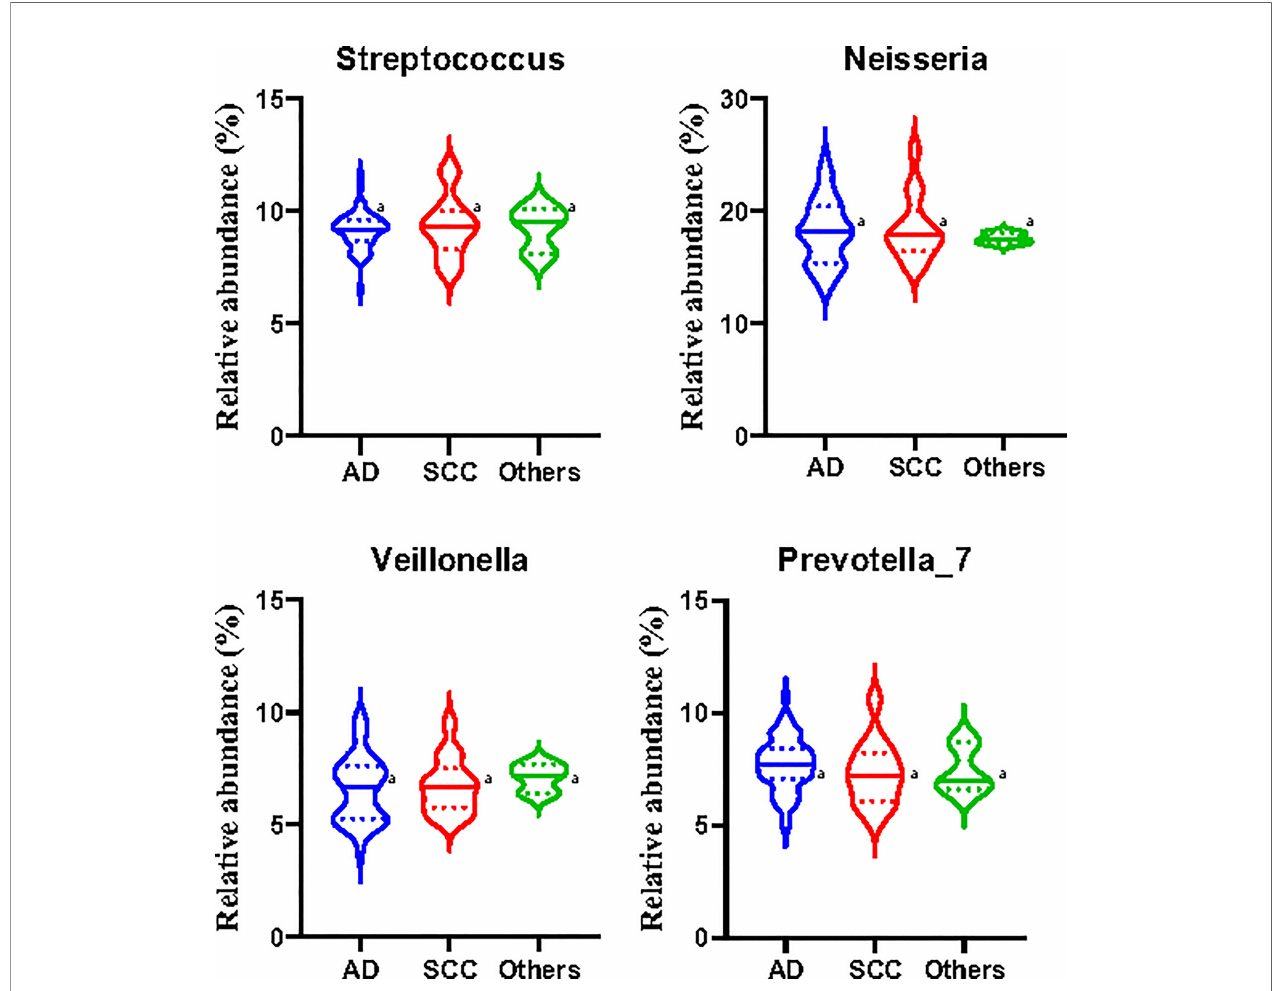
FIGURE 5 | Microbial community phenotypes in the induced sputa of patients with chronic obstructive pulmonary disease (COPD) and/or lung cancer. This community function was predicted using the BugBase web server for quantifying the relative abundance of the microbiome in nine categories. Data shown are the median ± quartile. Different letters indicate statistically signi fi cant differences. p <